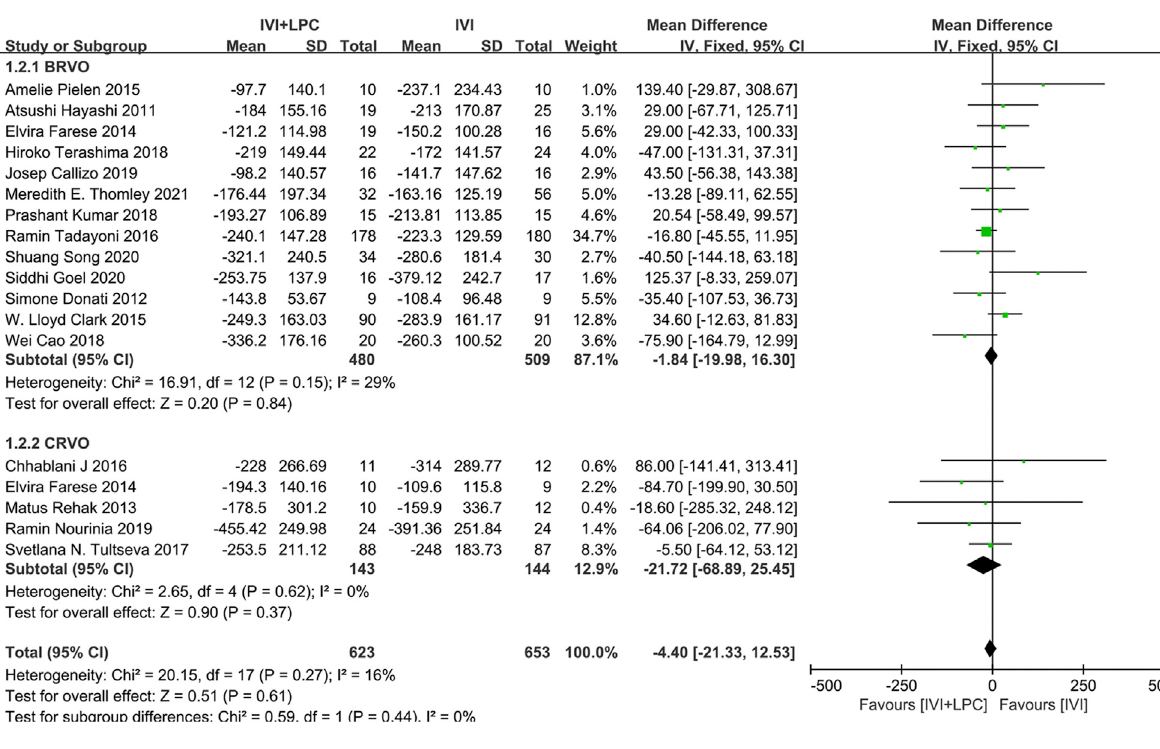
FIGURE 4 Comparison of CMT between combination(IVI + LPC) treatment group and single IVI treatment